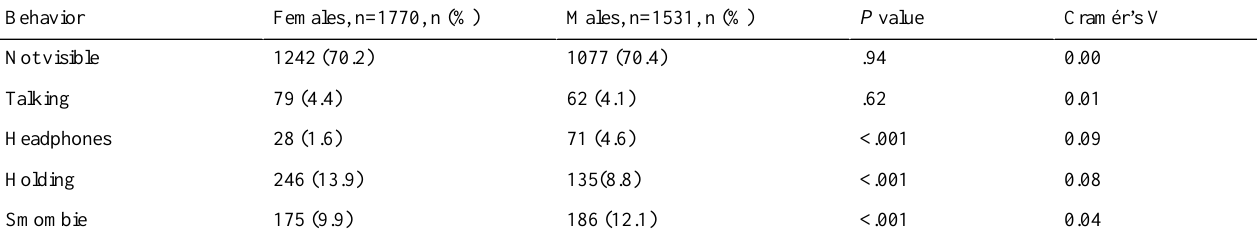
Table 2. Influence of the pedestrians’gender on smartphone usage